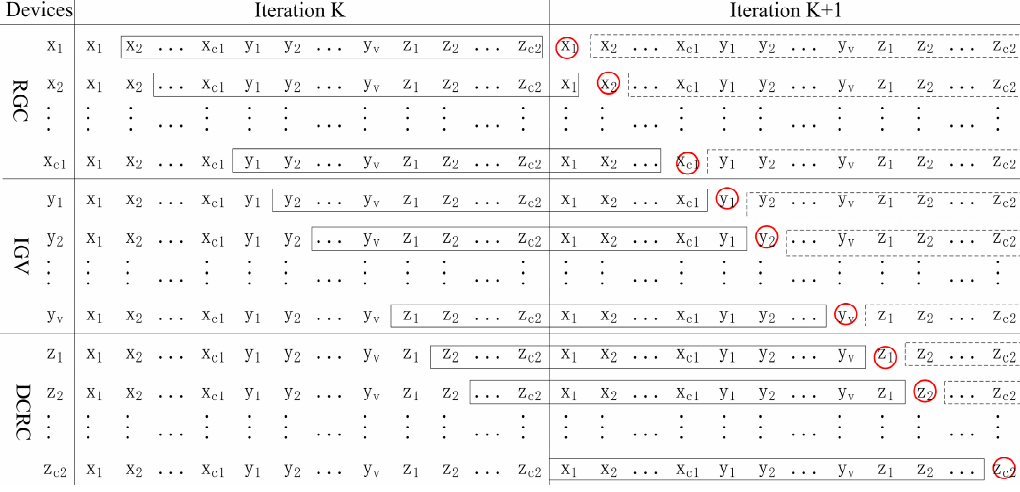
Figure 8. Rolling update scheme of ADMM for three devices.